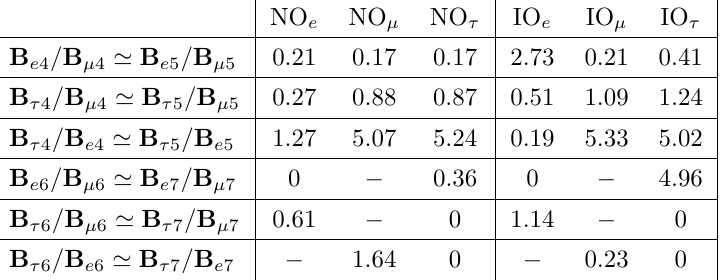
Table 7 . Predictions for ratios of heavy-light mixing parameters B αj computed using eq. (5.22). The results are shown for the NO